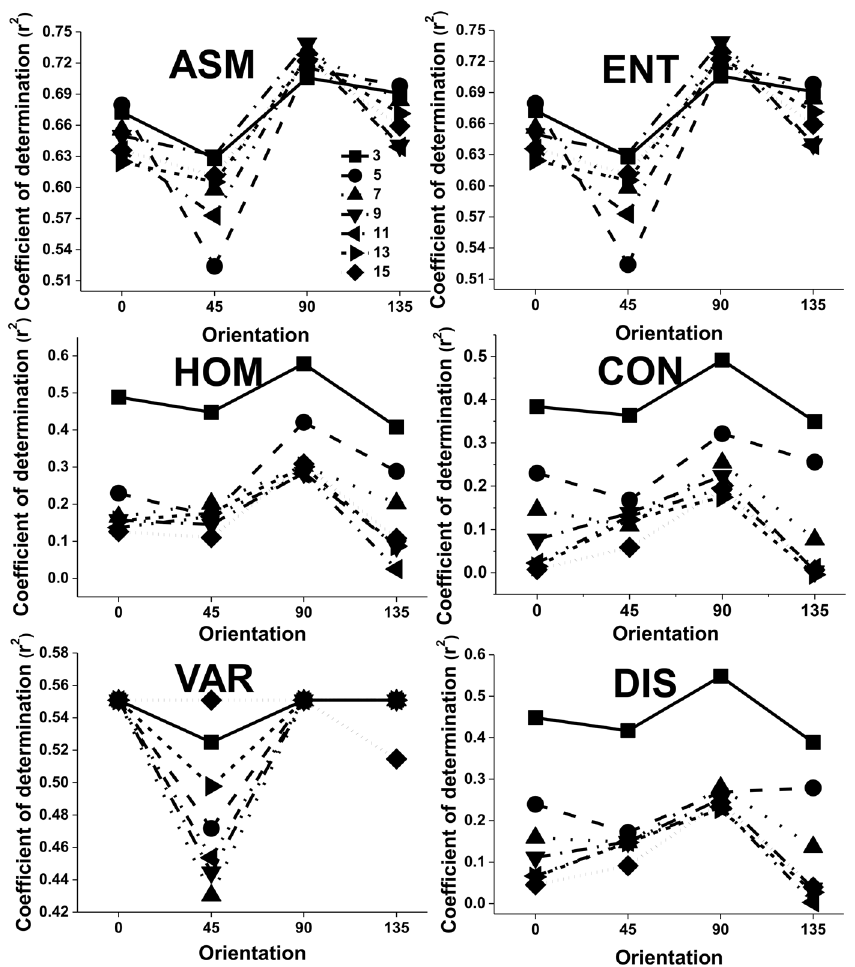
Figure 1. The effect of the orientation parameter on the values of adjusted r 2 for different texture features calculated using a 3 × 3 moving window size and 3, 5, 7, 9, 11, 13 and 15 pixels (ASM, CON, COR, DIS, ENT, HOM and VAR are abbreviations for Angular Second Moment, Contrast, Correlation, Dissimilarity, Entropy, Homogeneity and Variance,